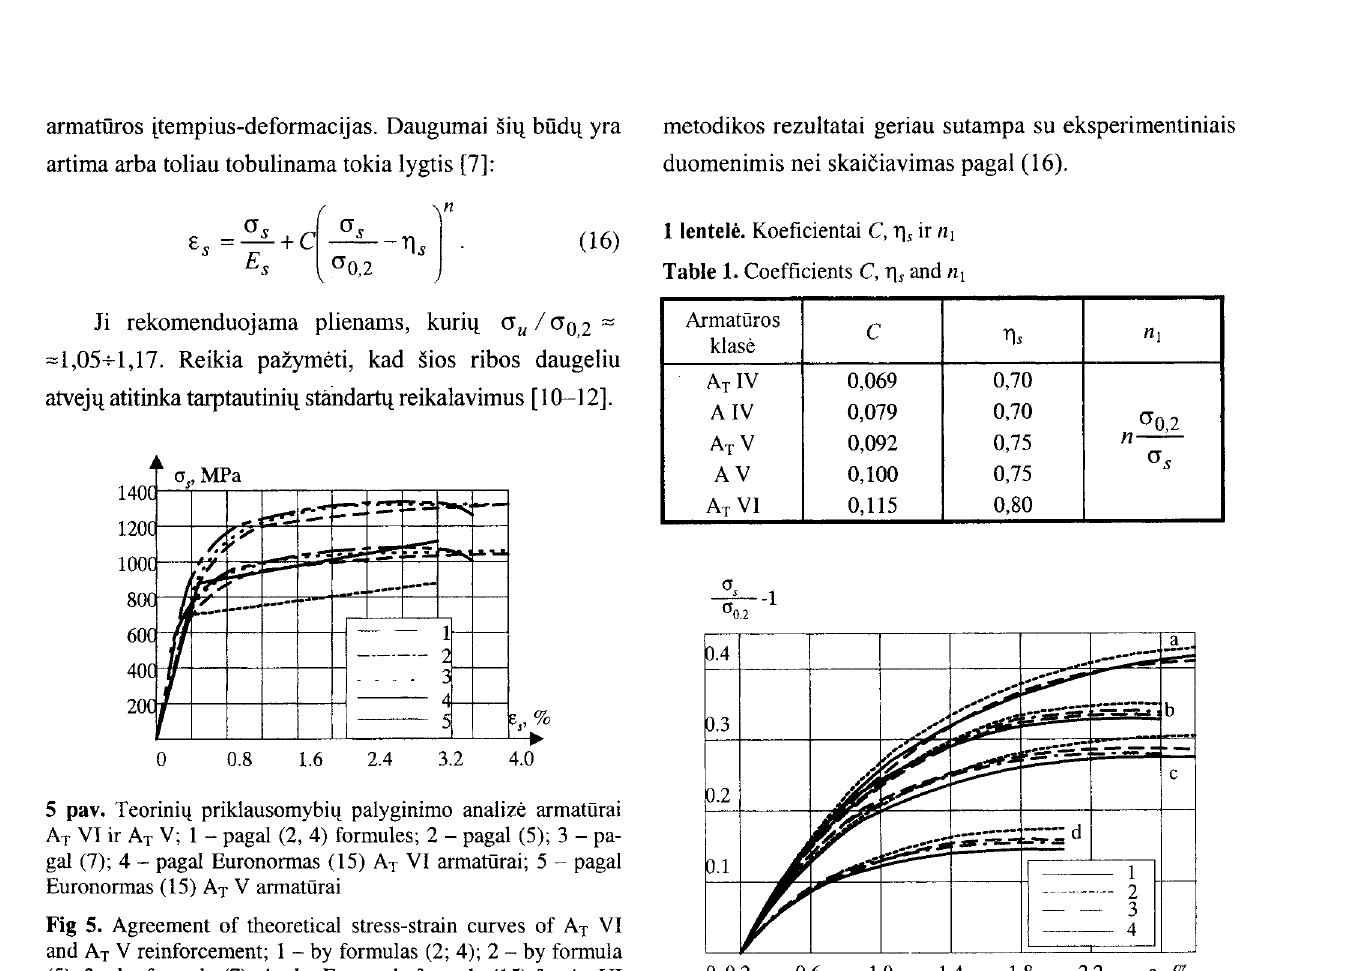
Fig 5. Agreement of theoretical stress-strain curves of AT VI and AT V reinforcement; 1- by formulas (2; 4); 2- by formula (5); 3- by formula (7); 4- by Eurocode formula (15) for AT VI reinforcement; 5- by Eurocode formula (15) for AT V reinfor cement Miistt atlikta analize taip pat rodo, kad (16) priklau somybe gali biiti taikoma ivairitt klasitt armatiiros defor mavimuisi aprasyti. J'lc palyginus su eksperimentiniais